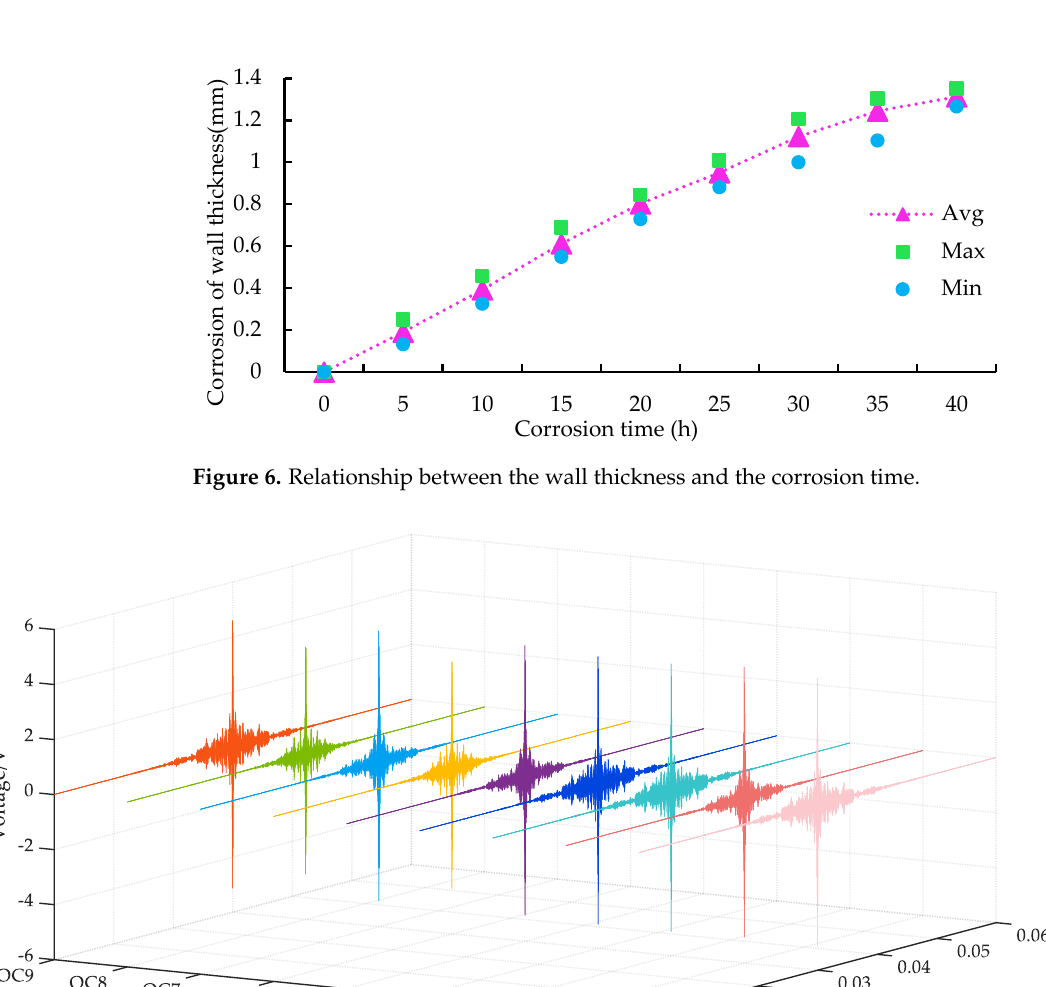
Figure 7. Focused signals under nine operating conditions.